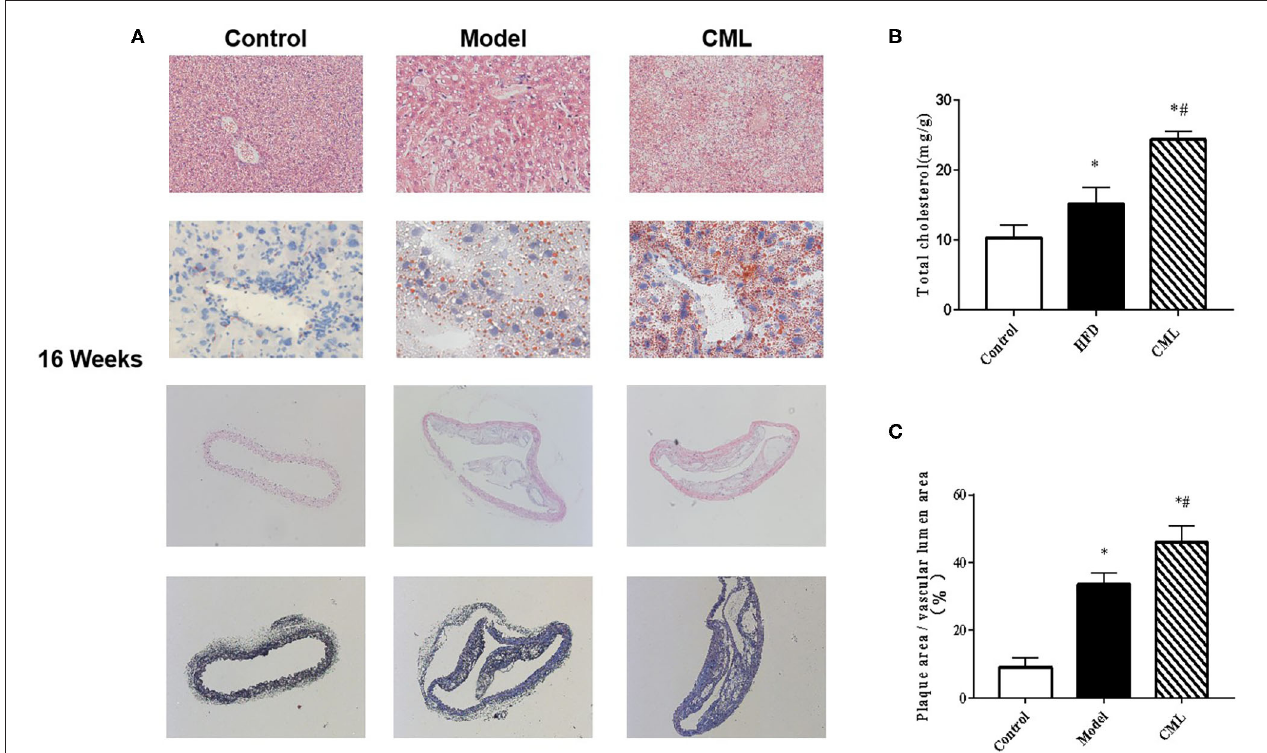
FIGURE 5 | Pathological changes of liver and aorta after ApoE − / − mice at the time of 16 weeks (A) . First row: H&E staining of ApoE − / − mice liver ( × 200). Second row: Oil Red O staining of ApoE − / − mice liver ( × 400). Third row: H&E staining of ApoE − / − mice aorta ( × 100). Fourth row: Masson staining of liver aorta in ApoE − / − mice ( × 100). (B) . Total cholesterol content in ApoE − / − mice liver (C) . Quantification of vascular plaque area by Image J. * P < 0.05, compared with control group; # P < 0.05, compared with model